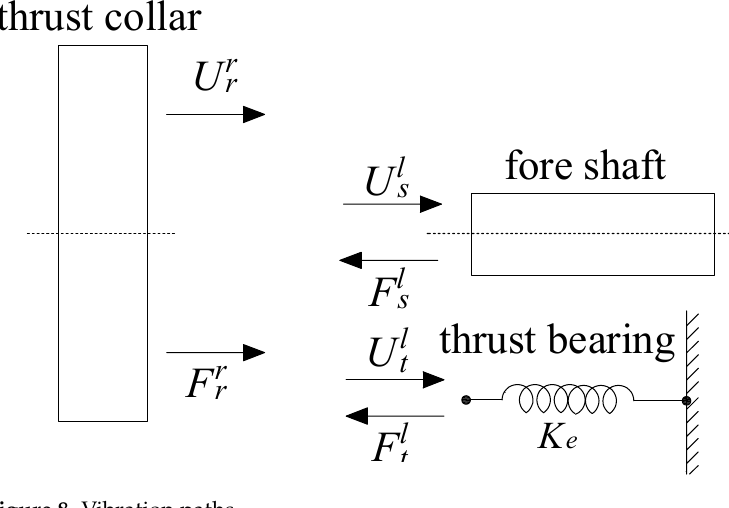
Figure 8. Vibration